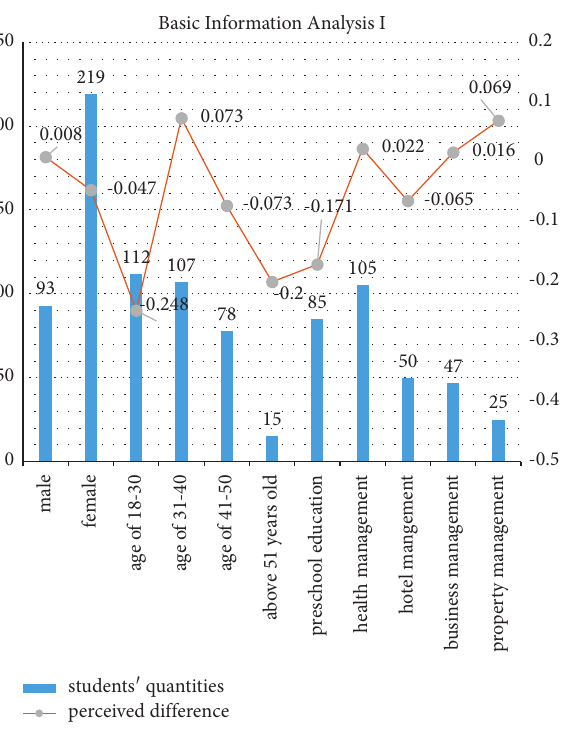
Figure 1: Basic information analysis